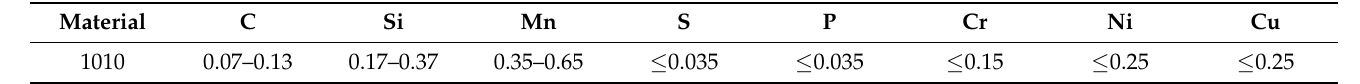
Figure 1. Schematic structures of a conically corrugated tube. Table 1. Chemical composition table of 1010 (wt %) [28].